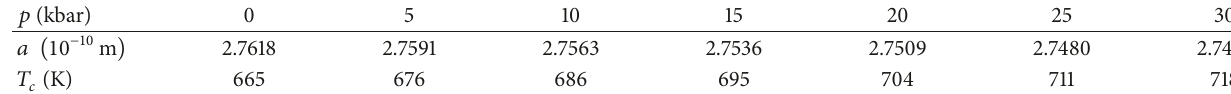
Table 1: Solutions of (13) at different pressures (𝜔/𝑘 𝐵 = 910.6 K ) .